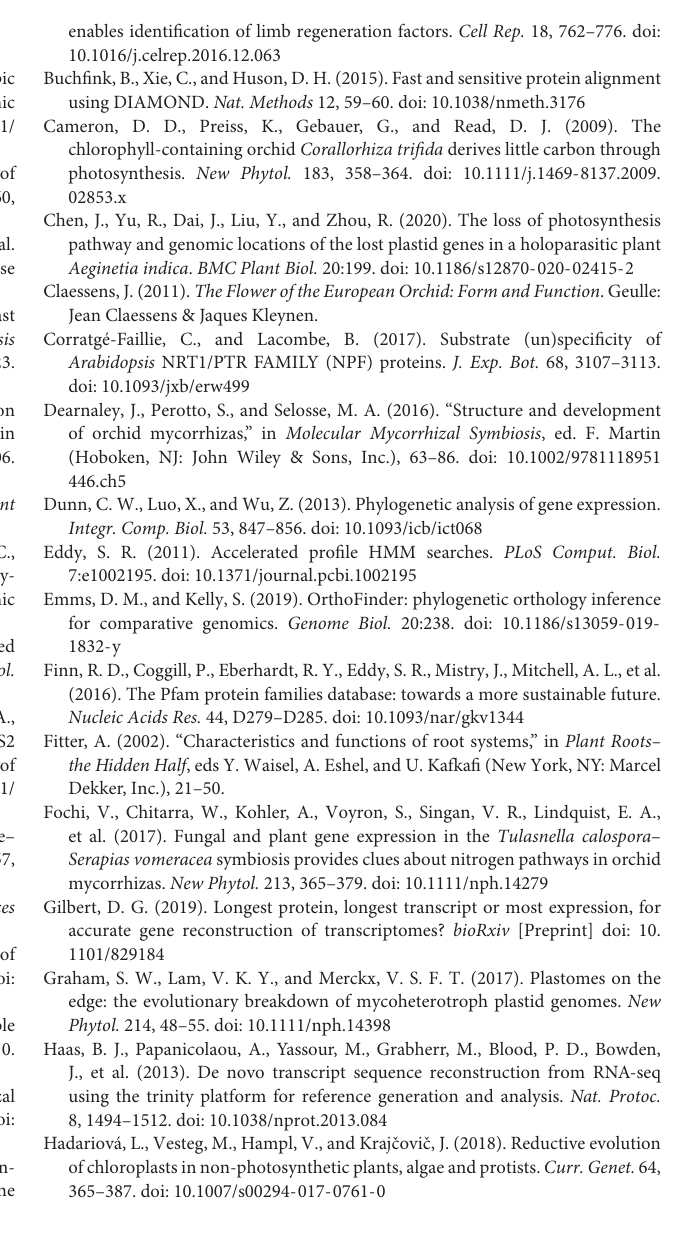
Supplementary Table 8 | Per-species statistics among the generated orthologous groups. Supplementary Table 9 | Species overlaps among orthologous groups. Supplementary Data 1 | Distribution of GO terms in the three mycoheterotrophic orchids. Only the 20 most abundant terms for each species and each ontology are